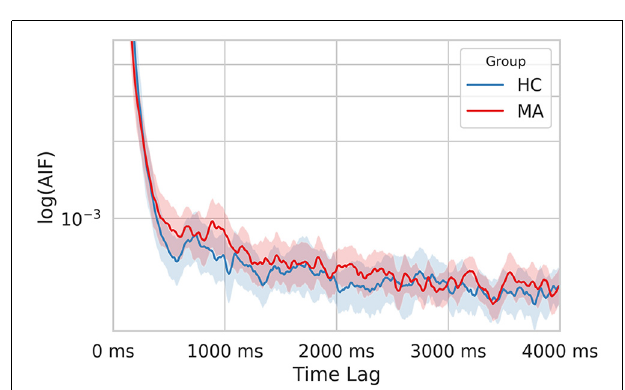
FIGURE 6 | The semi-log time-lagged mutual information plot for the MA and HC groups at different time lags. The shaded area represents the 95% confidence intervals for each